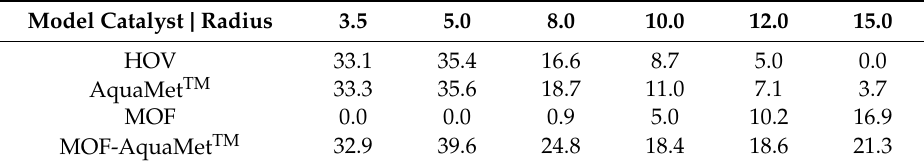
Figure 5. Topographic steric maps of the section of the MOF (plane xy) from the X-ray: ( a ) orientation of the axis; ( b ) HOV with a radius of 3.5 Å; ( c ) MOF with a radius of 10 Å and ( d ) MOF-AquaMet TM with a radius of 10 Å. The linking C atom of the NHC is on the z axis, and the metal atom is 2 Å below the plane described by the metal and both chloride atoms. The isocontour curves of the steric maps are given in Å. Table 6. %V Bur for catalysts HOV, AquaMet TM , MOF and MOF-AquaMet TM , calculated at radius 3.5, 5.0, 8.0, 10.0, 12.0 and 15.0 Å.